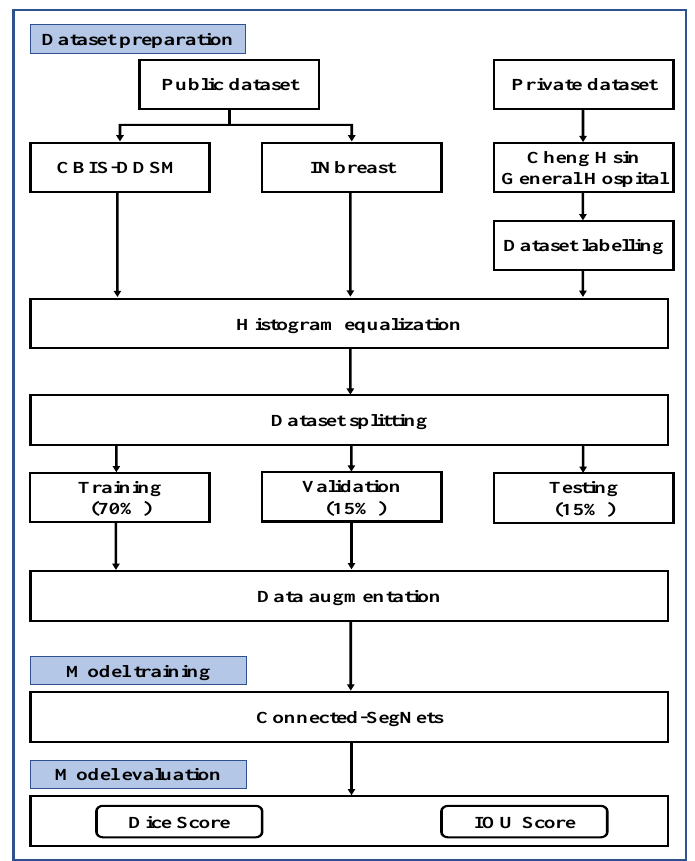
Figure 1. Flow chart of the proposed tumor segmentation